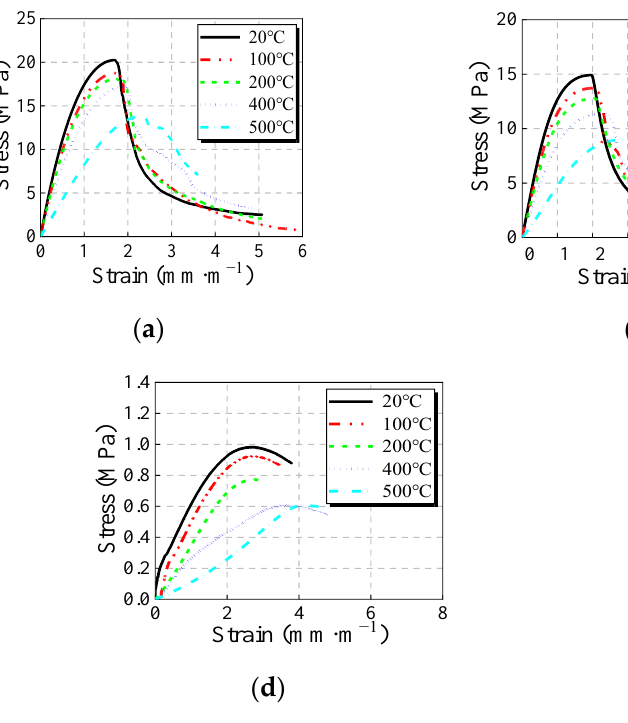
Figure 6. Stress–strain curves for JNC under the same replacement ratio after experiencing the various elevated temperatures. ( a ) r = 0%. ( b ) r = 25%. ( c ) r = 50%. ( d ) r = 75%. ( e ) r = 100%.